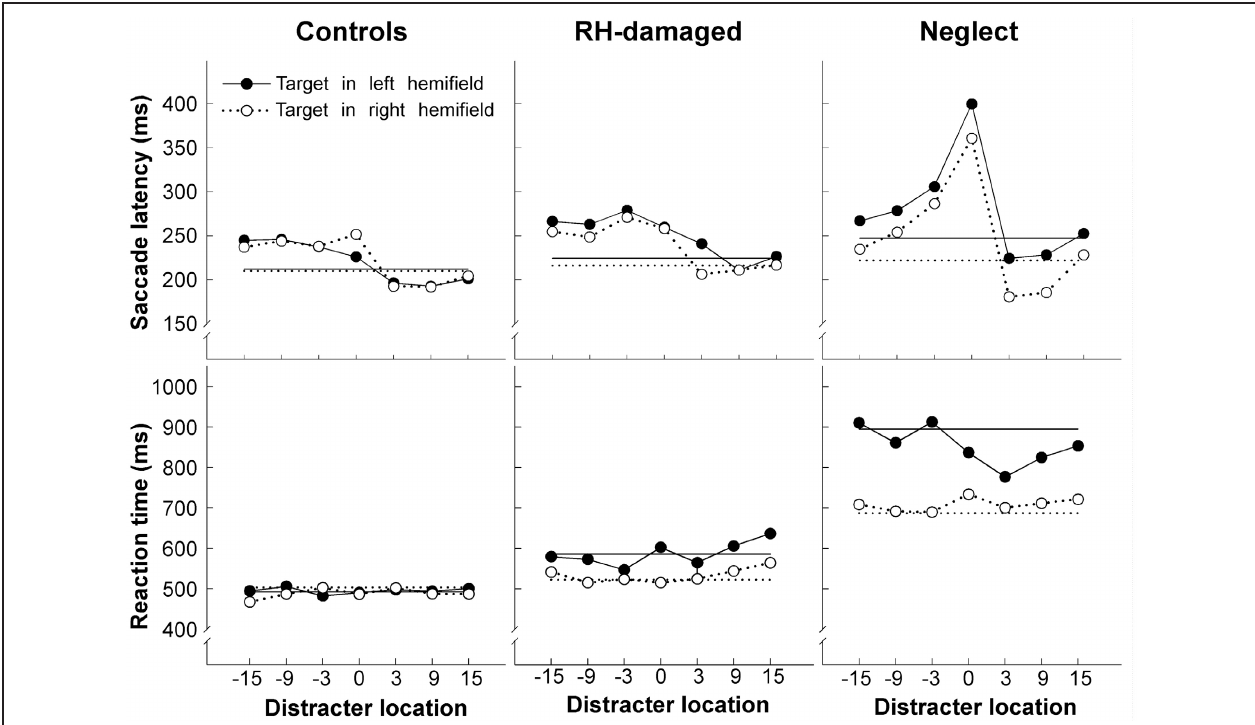
and distracters in the right hemifield on the left side of each graph). The straight horizontal lines show average latency/reaction time when no distracter was presented. Note the increase of saccade latency for neglect patients when the distracter was presented at fixation (position 0). Figure adapted from Ptak et al. (2007) by permission from Oxford University